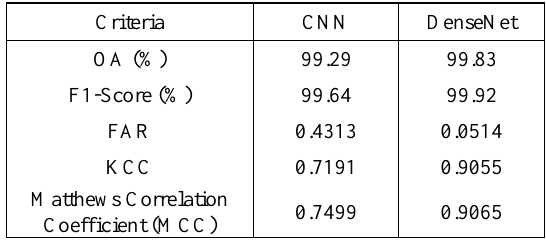
Table 4 . The accuracy assessment measurements for a standard CNN algorithm and proposed DenseNet